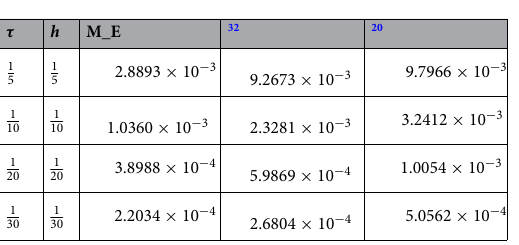
Table 6. Comparison of the proposed scheme Eq. (7) with 32 and 20 for the Example 1, where γ = 0.6 .